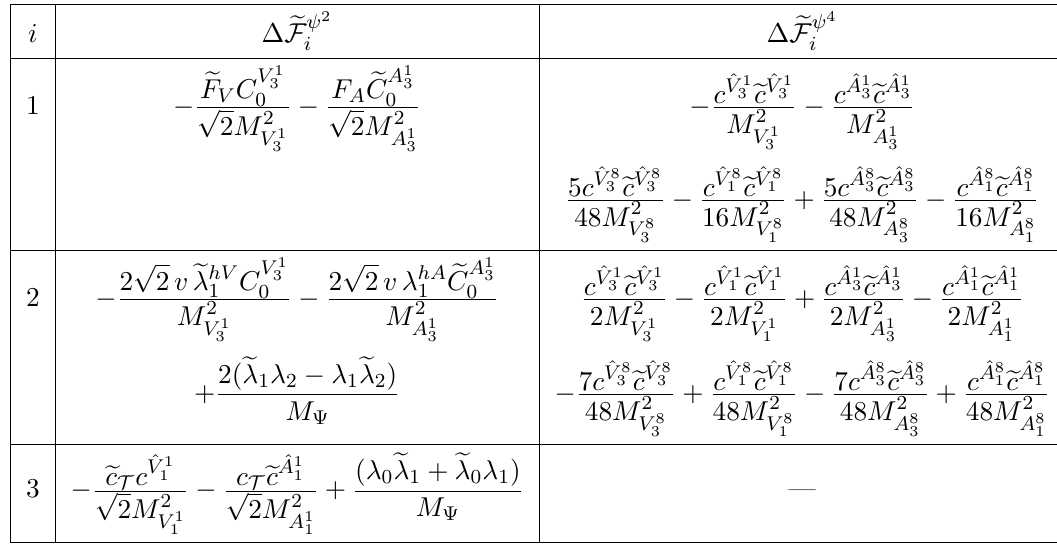
Table 6 . Contributions to the O ( p 4 ) LECs of two- and four-fermion P -odd operators from heavy scalar, pseudoscalar, vector, axial-vector and fermionic